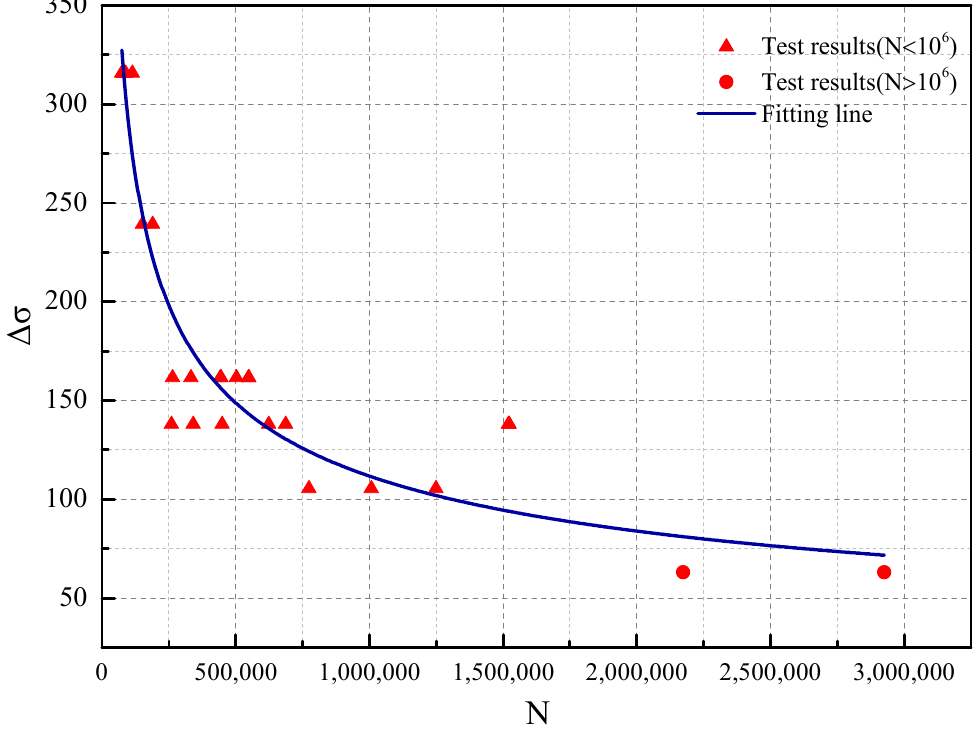
Figure 8. The stress–fatigue life relationship: the M60 high-strength bolt’s S–N curve.